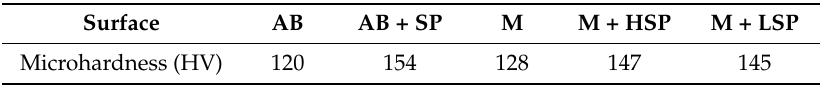
Table 5. Surface microhardness of the AlSi10Mg samples under various